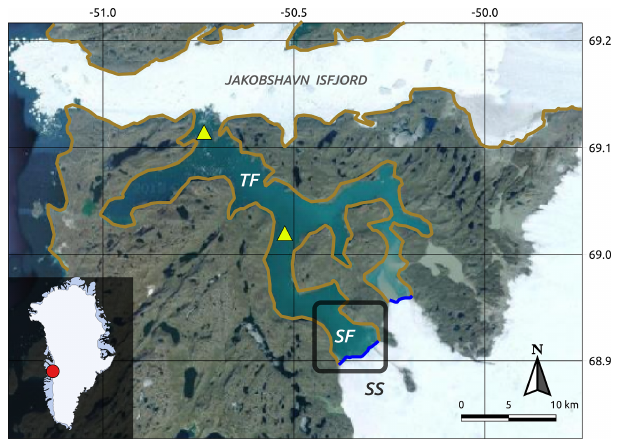
Figure 1. Location map of Saqqarleq Fjord–Saqqarliup Sermia (SF–SS) system (composite image from the U.S. Geological Survey and © Google Earth, 2019). Coast lines (light brown) and glacier fronts (blue) have been superimposed. Yellow triangles indicate sill locations. The dark rectangle corresponds to the SF–SS area shown in Fig. 2. The inset shows the location in central-western